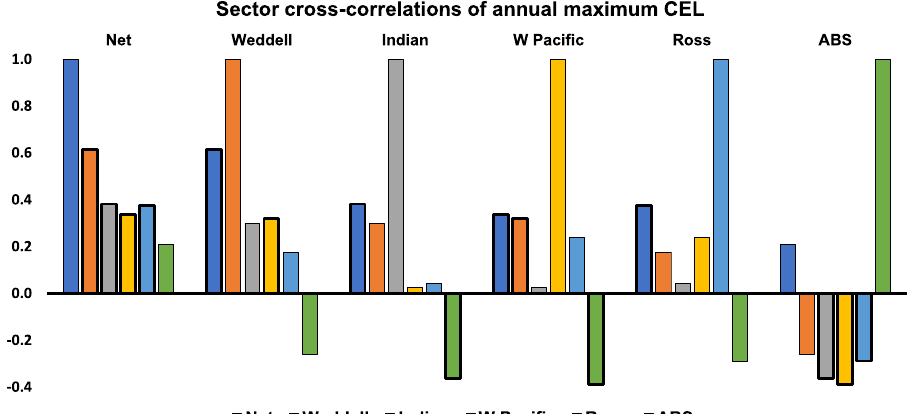
Fig. 4 Trends sector cross-correlations of annual maximum based on coastal exposure length. Statistically signi fi cant values (>95% con fi dence) are shown